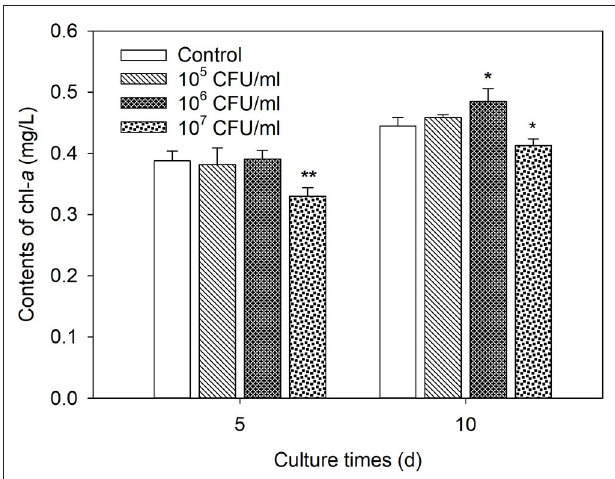
FIGURE 3 | The influences of inoculation dosages and culture times of strain JXJ CY 35 T on the growth of Maf. The pure culture of Maf served as the control. Error bars indicate standard deviations for the three replicates. *, ** Indicate the significant differences between the control and the tests inoculated with different dosages of strain JXJ CY 35 T at the levels of P < 0.05 and P < 0.01.